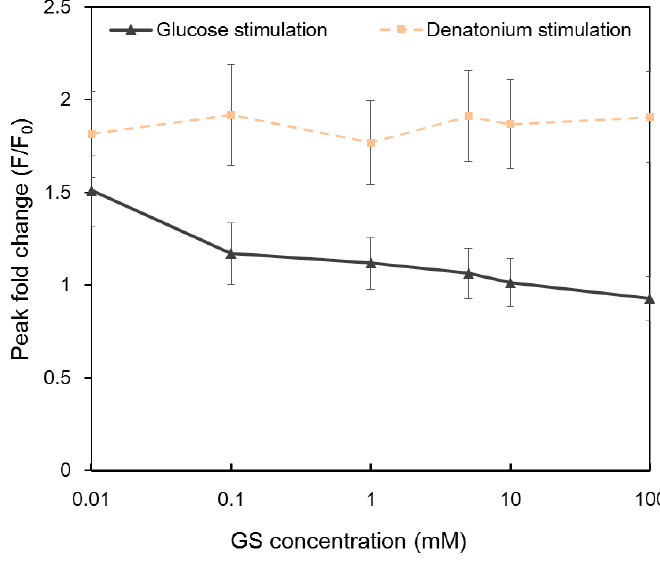
Figure 5. Intracellular Ca 2+ response of single NCI-H716 cells stimulated with 10 mM glucose and denatonium benzoate after being treated with different concentrations of Gymnema sylvestre (GS) solutions. Cells were rinsed with calcium-free basal salt solution between different stimuli. Images were taken from the entire array of cells. A total of 955 cells in two automatic microfluidic chips were imaged.